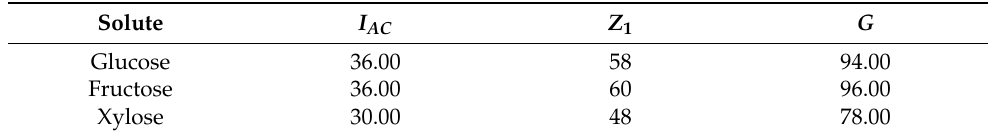
Table 4. Information index on atomic composition ( I AC ), first Zagreb number ( Z 1 ), and global information index ( G ) for the investigated